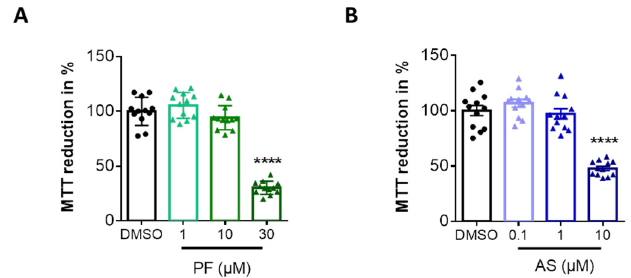
Figure 1. Evaluation of cytotoxicity of PF8380 and AS2717638 in BV-2 microglia . Cells were treated with increasing concentrations of ( A ) the ATX inhibitor PF8380 (‘PF’) and ( B ) the LPA5 inhibitor AS2717638 (‘AS’) for 24 h. Dimethylsulfoxide (DMSO) was used as vehicle control. Dose-dependent effect of the inhibitors on MTT reduction in cells was compared to control. Results are shown as mean ± SEM of three independent experiments. (**** p < 0.0001, compared to control; one-way ANOVA with Bonferroni correction).